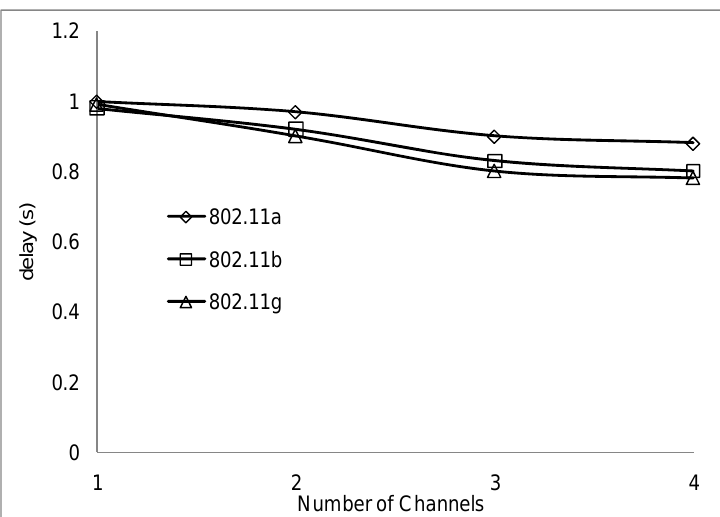
Figure 21. Delay occur at 100 m range and data rate of 10